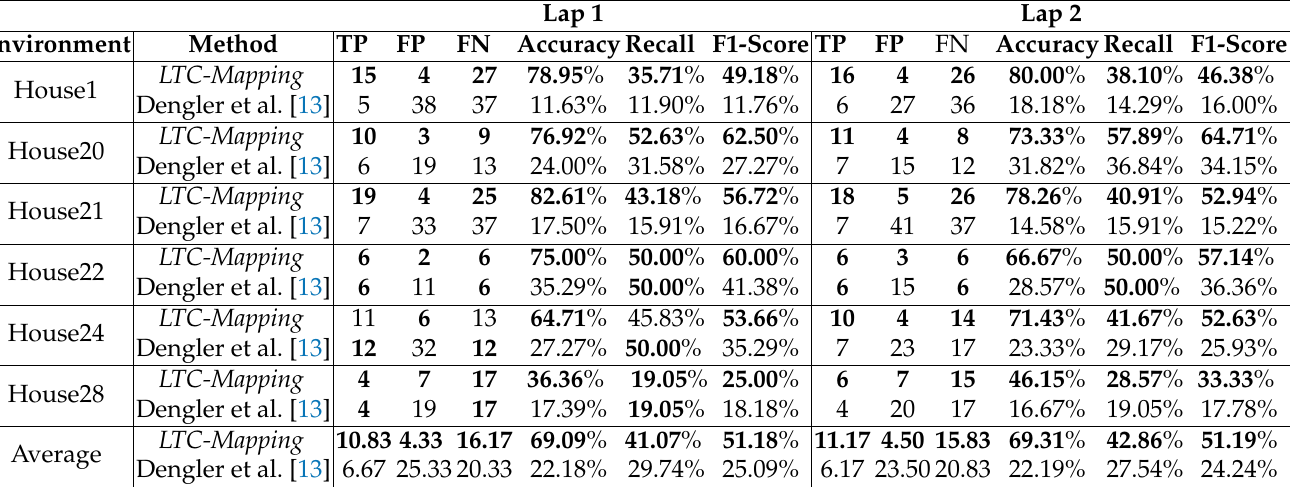
Table 2. Evaluation of the semantic information available in the maps built by each evaluated method for each environment. The metrics employed refer to the number of true positives (TP), false positives (FP), false negatives (FN), accuracy, recall, and F1-score. Note that, for this evaluation, we compare the top-1 class of each object represented in the map with the label of the ground-truth. Best results are marked in